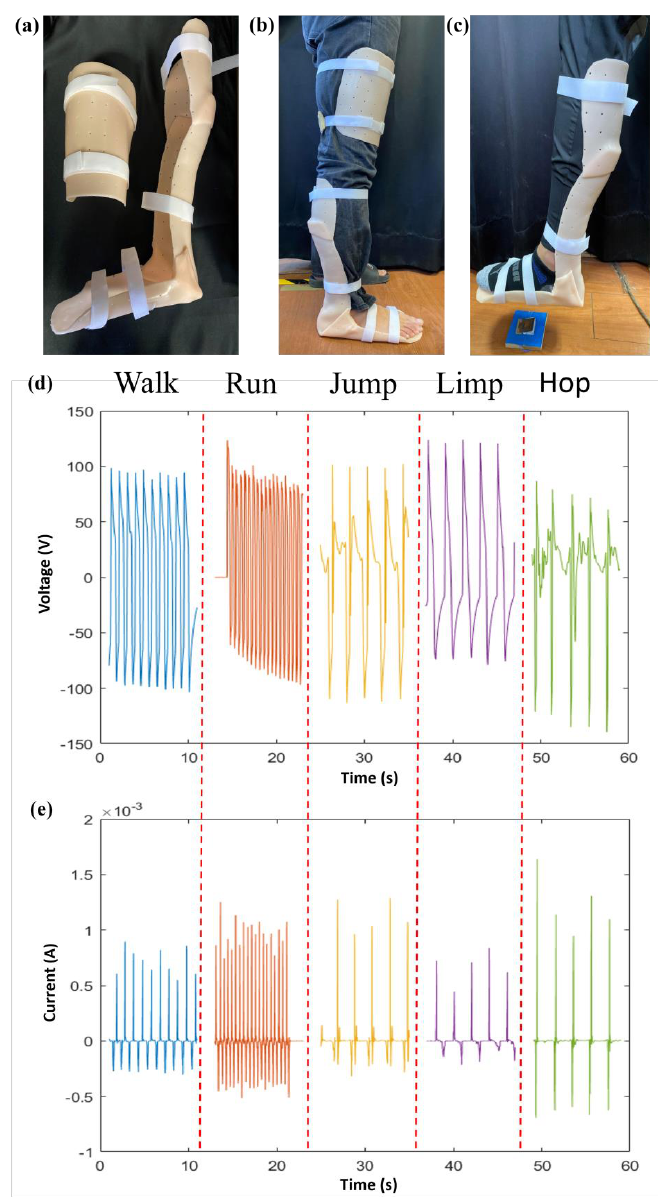
Figure 5. Response to different types of action modes while wearing a leg-rehabilitation device. ( a ) Picture of rehabilitation device. ( b ) Picture of a test subject’s leg while wearing the rehabilitation device. ( c ) The relative position of the wearable rehabilitation device and the SPMS. ( d ) The data on the voltage output of five different action modes (walk, run, jump, limp, hop) while wearing a rehabilitation device. ( e ) The current measurement of five different action modes.